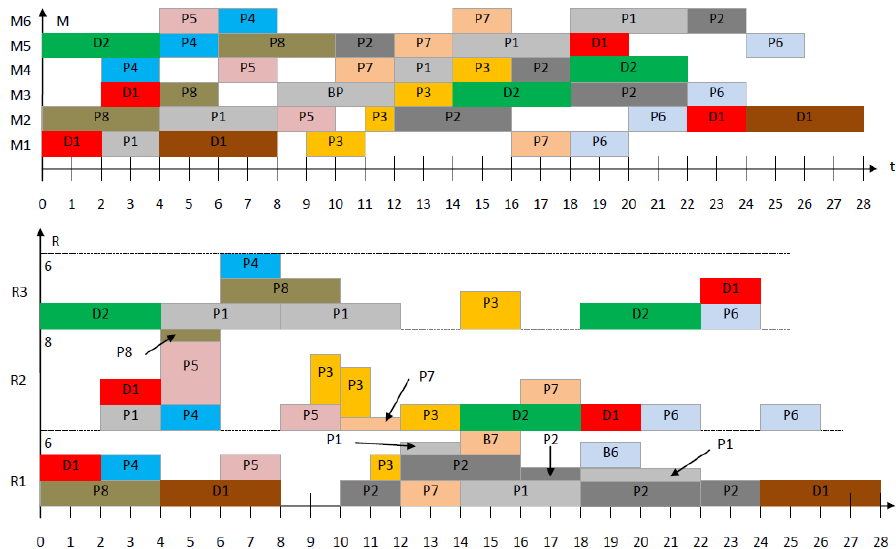
Fig. 8. Gantt charts which visualize the answer to the question Q 14 (upper one: the allocation of machines and lower one: the use of additional